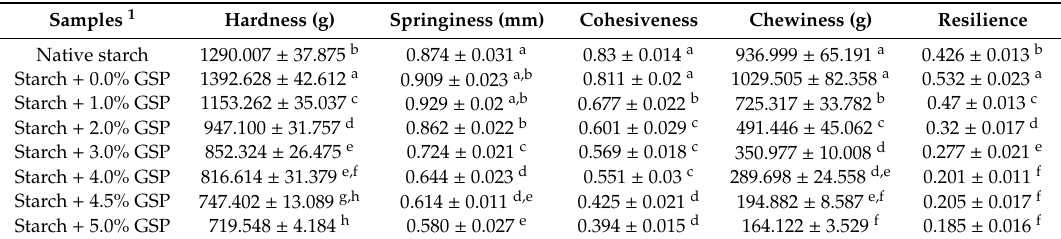
Table 4. Texture profile analysis of native potato starch and GSP-potato starch complexes